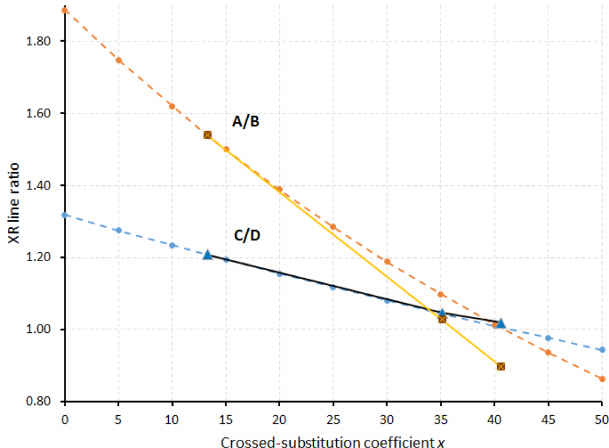
Figure 8. Variation in the A/B and C/D ratios as a function of the crossed-substitution coefficient x . Yellow line: interpolation on the basis of A/B ratios of Table 8 (brown squares); black line: in- terpolation on the basis of C/D ratios of Table 8 (blue triangles). Orange and blue tie lines: extrapolations of A/B and C/D ratios, respectively, on the basis of F1 crystal structure (lowest x value) as starting point for calculations.